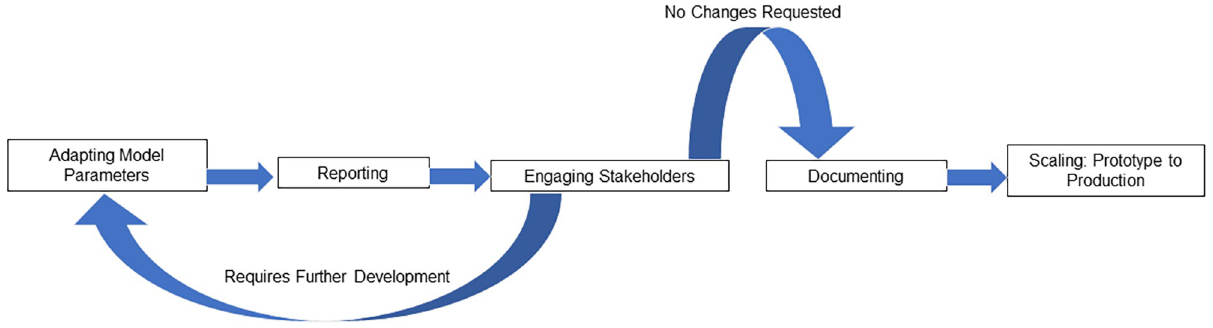
Fig 1. Model adaptation